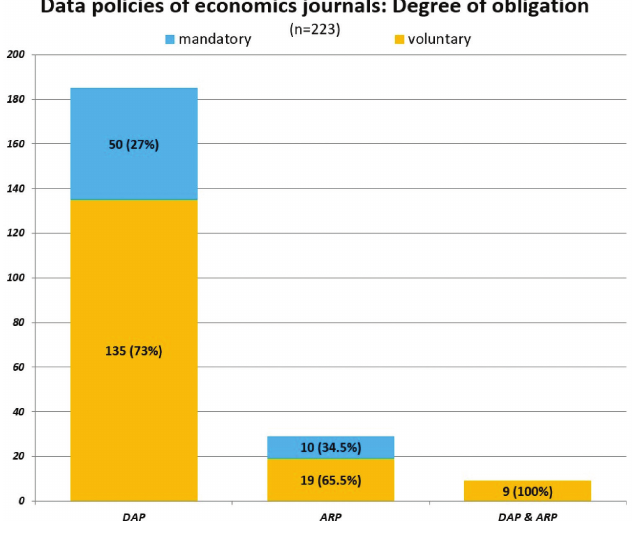
Fig. 2: Degree of obligation of the different types of data